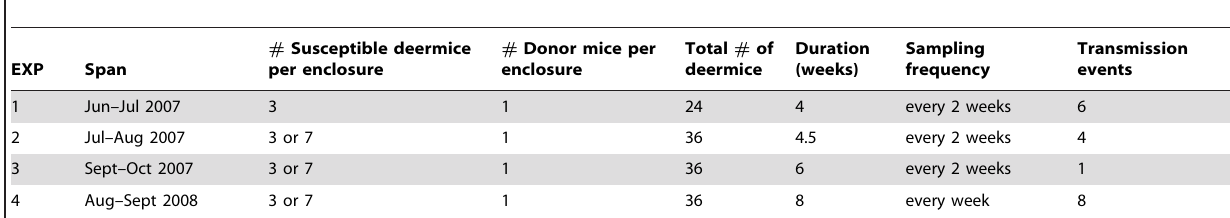
Table 1. Experimental design for Sin Nombre hantavirus (SNV) transmission experiments in North American deermice ( Peromyscus maniculatus ) in outdoor enclosures in